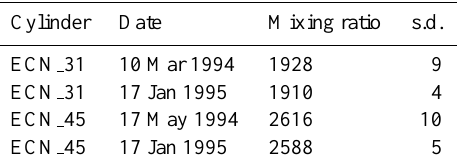
Table 3. Estimated precision of the measurements at Cabauw for the different measurement configurations, based on measured Tar- get repeatability